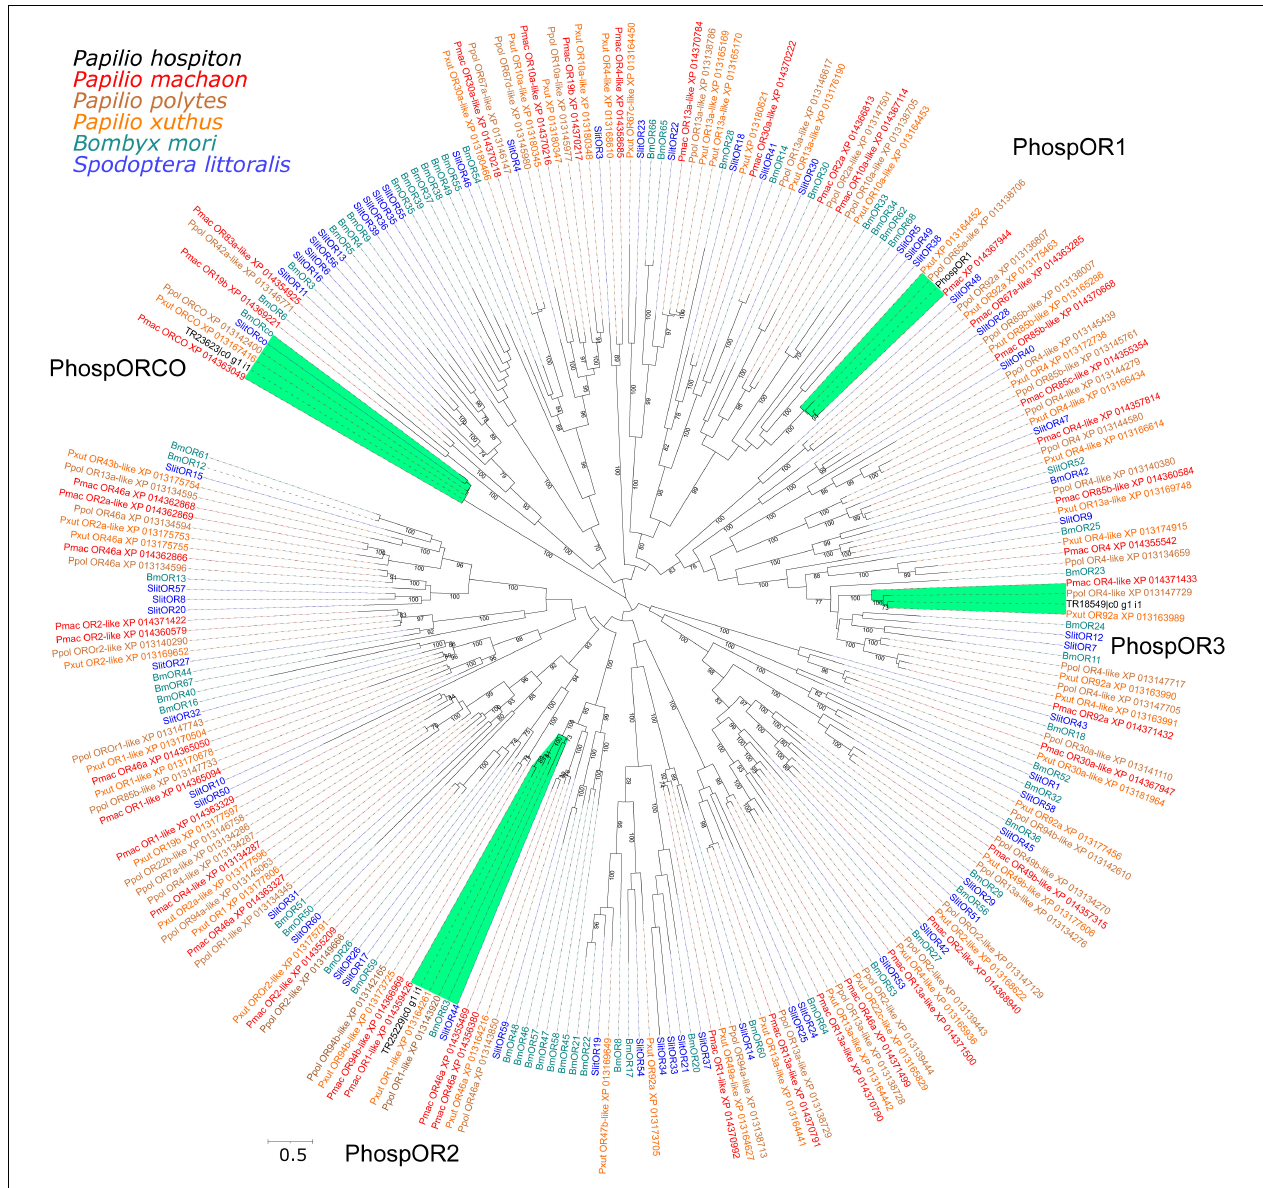
FIGURE 2 | Phylogeny of P. hospiton maxilla-expressed odorant receptors (ORs). A maximum-likelihood tree was built with OR repertoires extracted from automatically annotated genomic datasets of P. machaon , P. xuthus , and P. polytes (Li et al., 2015) using RAxML. Manually curated B. mori (Nakagawa et al., 2005; Tanaka et al., 2009) and S. littoralis ORs repertoires (Walker et al., 2019) are included. For PhospOR1 we used the full-length coding sequence amplified from cDNA instead of the two fragments obtained from RNA-seq. The tree was re-rooted on Orco clade. Labels highlighted in green refer to sequences that form a monophyletic group together with P. hospiton sequences. Branch lengths are scaled by the number of nucleotide substitutions per site. Bootstrap values refer to 500